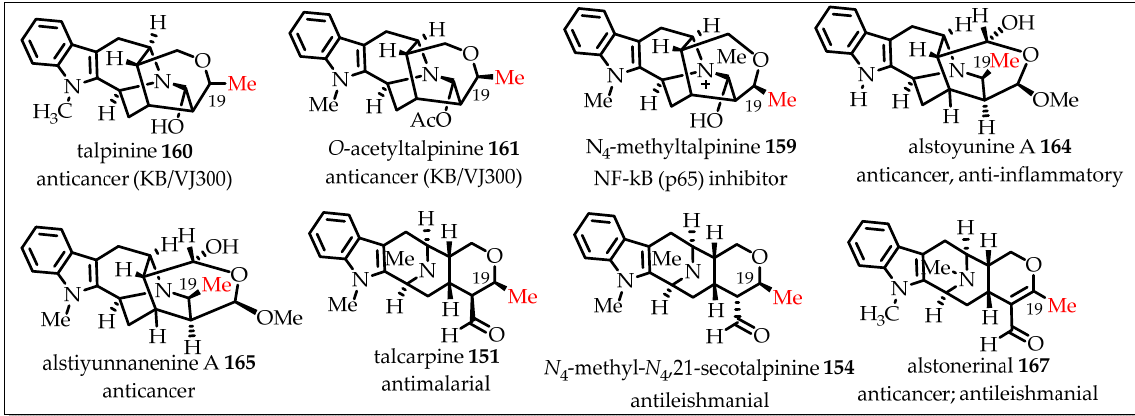
Figure 8. Representative examples of C-19 methyl-substituted monomeric sarpagine/macroline-related alkaloids from Alstonia species and their bioactivity.